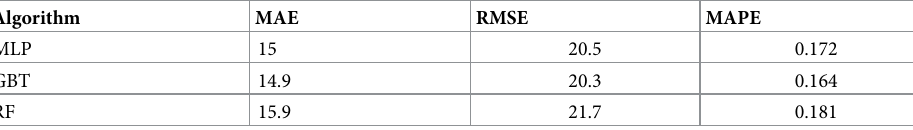
Table 6. DOS models’ performance (in